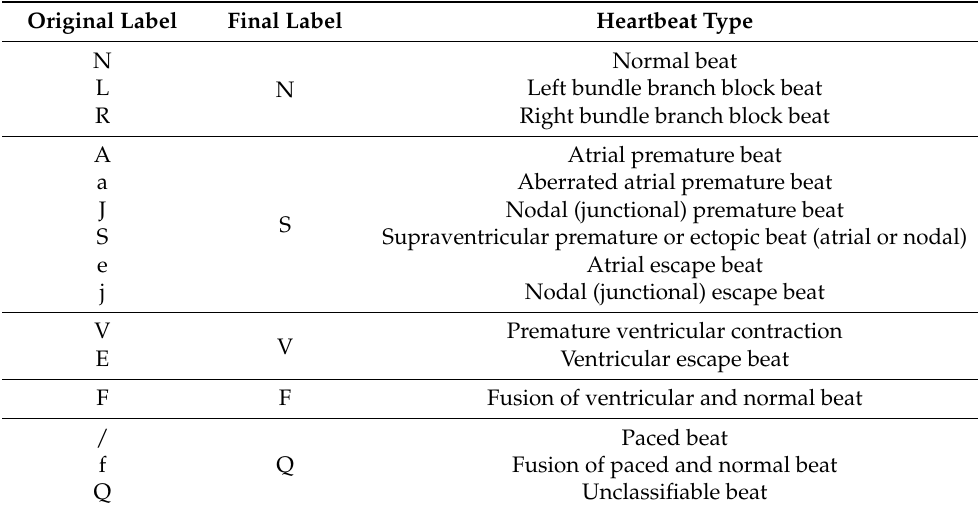
Table 2. Mapping of heartbeat classification labels for ECG signals.